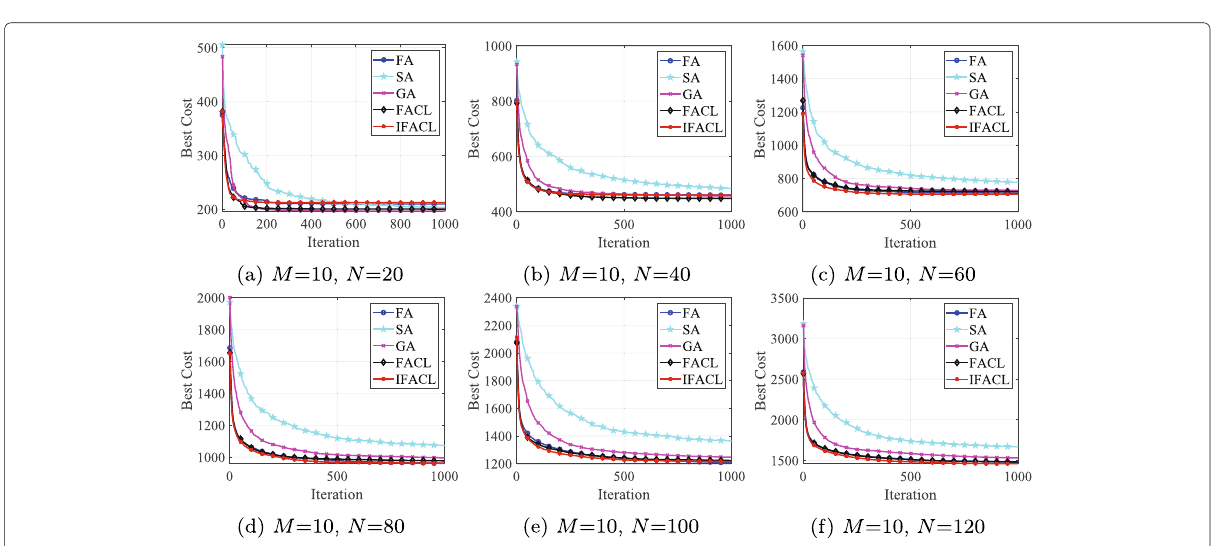
Fig. 5 Average convergence curve for each algorithm on P , SBalanced instances of Dataset1 when the number of machines M